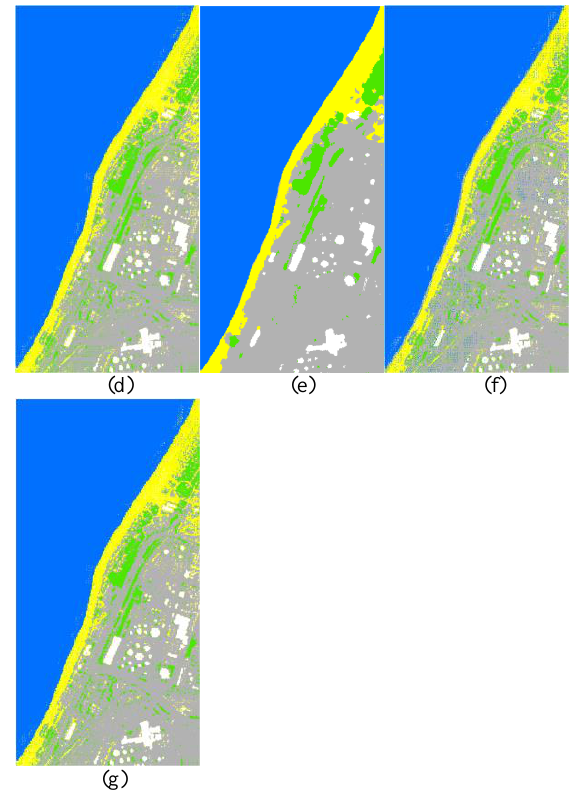
Table 1. Accuracy assessment of soft classification methods